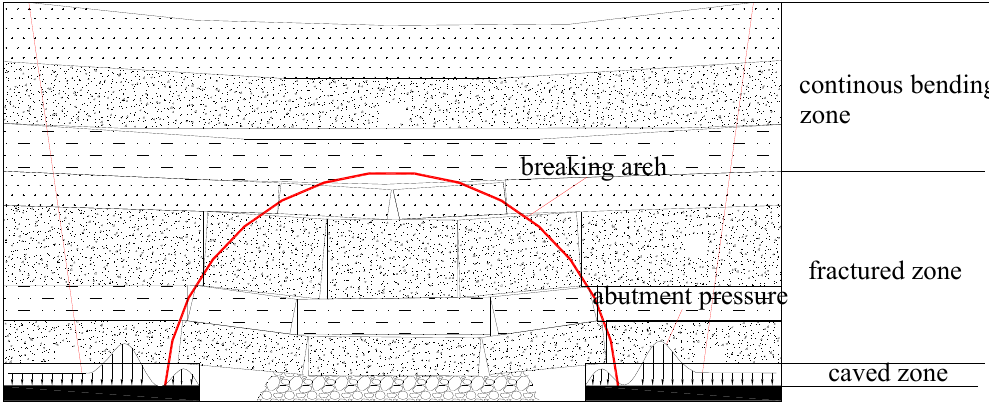
Figure 16. Strata movement characteristics in longwall mining.